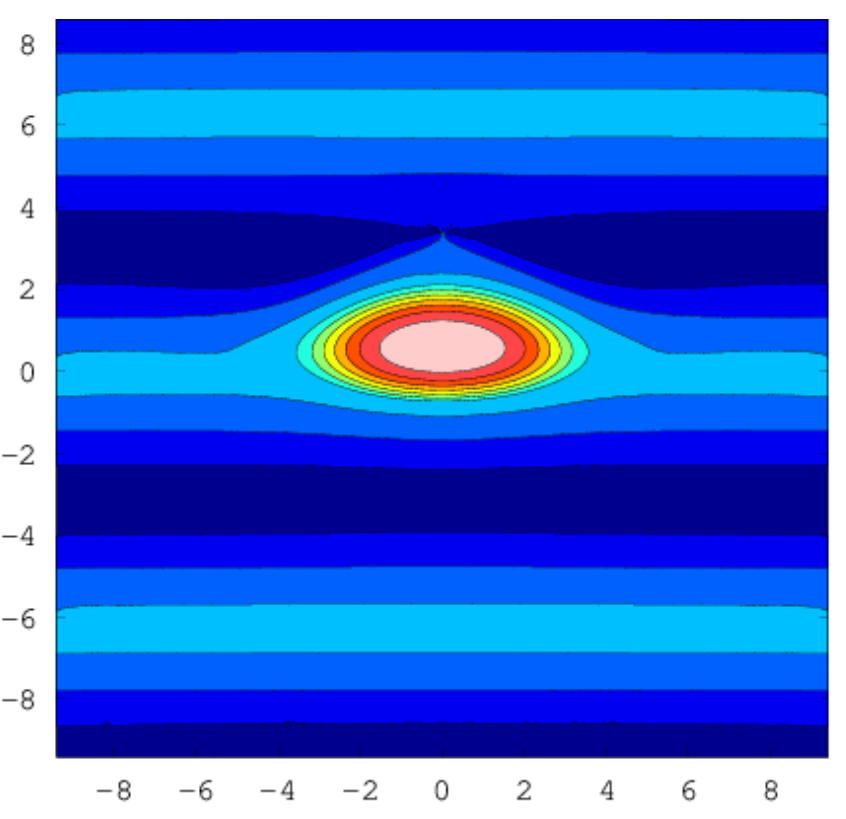
Figure 6. Potential vorticity q for a vortex centered at y = 1. The translation speed is c = −